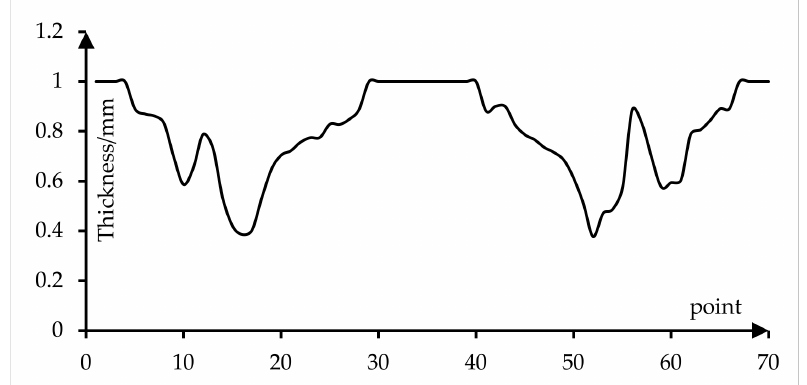
Figure 34. Thickness-distribution curve.